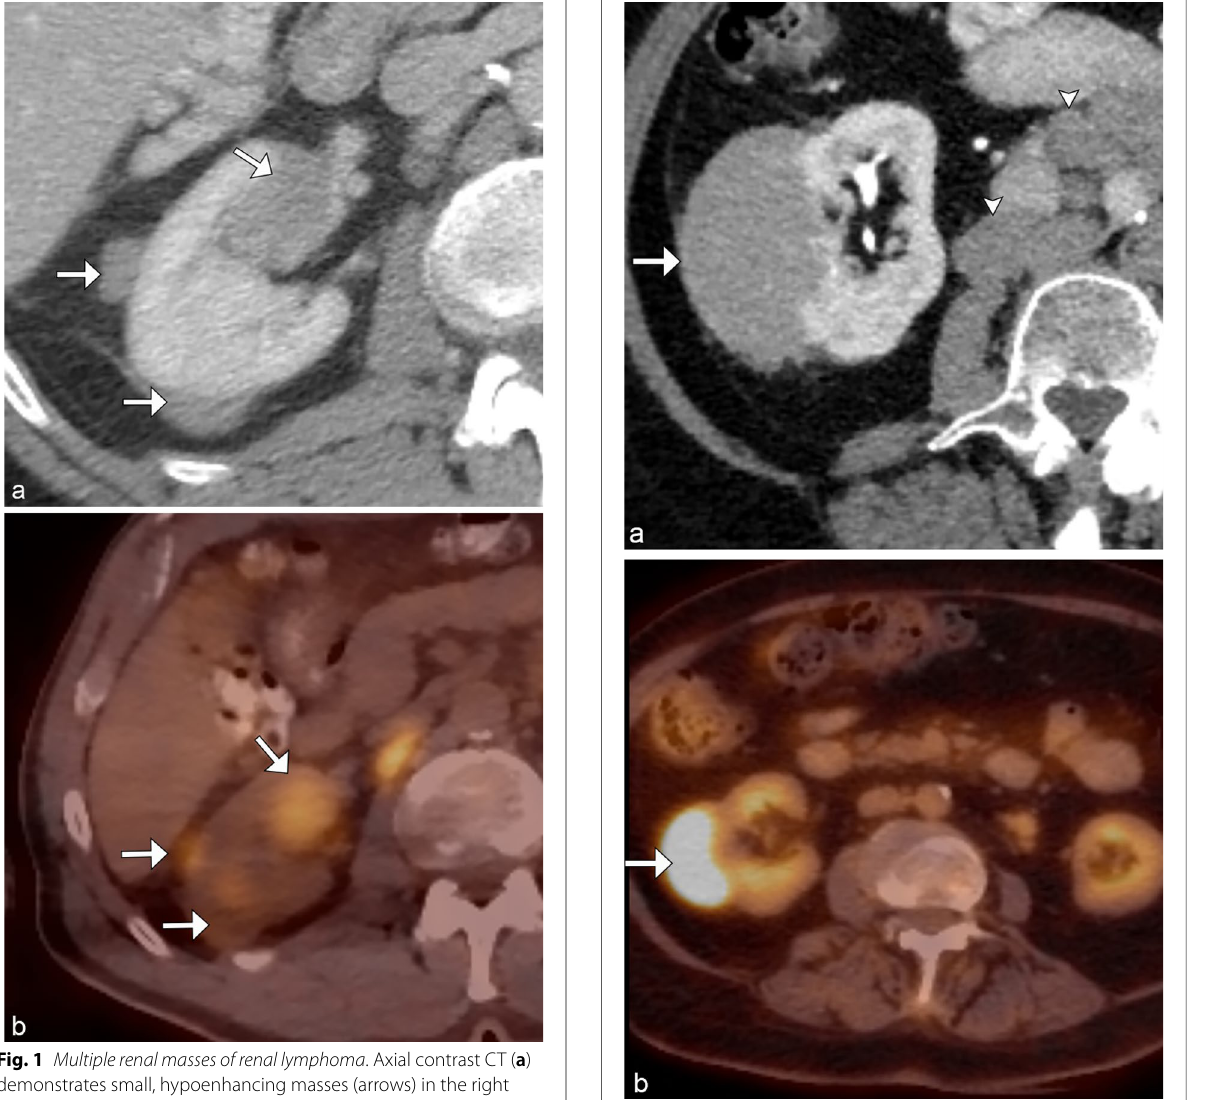
disease are present, these are helpful clues in diagnosing secondary renal lymphoma (Figs. 3 and 4).